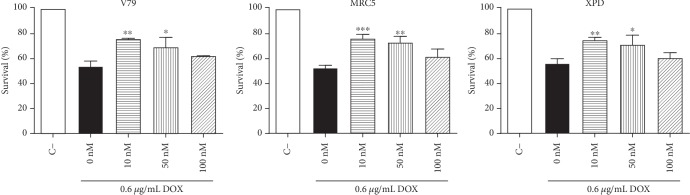
Protective effect of 2 h DPDT pretreatment in serum-free medium on doxorubicin-induced cytotoxicity in Chinese hamster fibroblasts (V79) as well as in human fibroblasts proficient (MRC5) and deficient (XPD) in NER evaluated by MTT assay 72 h after pretreatment. Data are reported as means ± SD of three independent experiments. Significantly different at ∗p < 0.05 and ∗∗p < 0.01 compared with cells treated with doxorubicin only (one-way ANOVA followed by Tukey test).